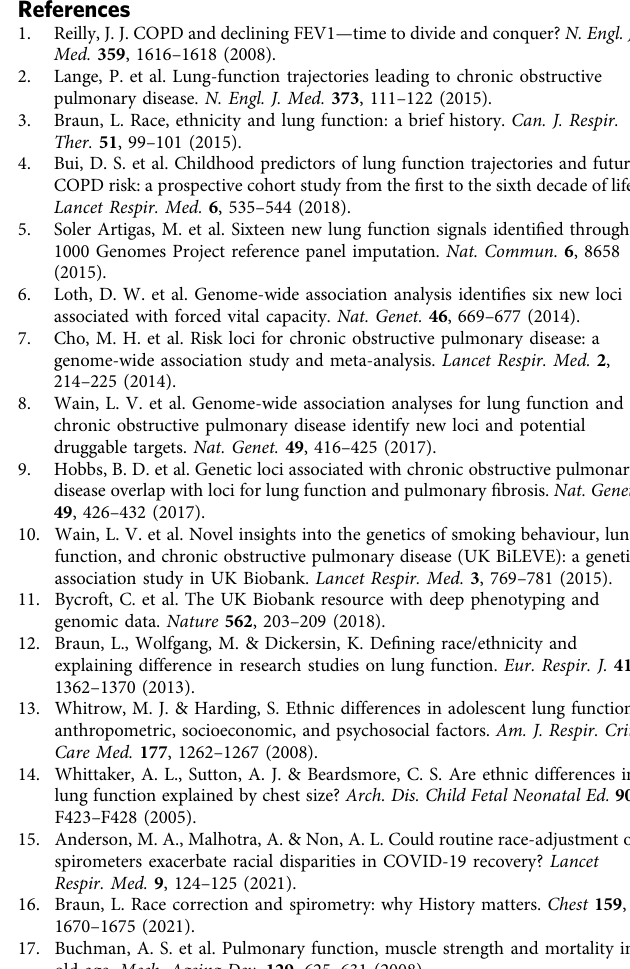
tableau.com/app/pro fi le/musalula.sinkala7788/viz/FEV1VariantsbyChromosome/Chromosome Filter, https://public.tableau.com/app/pro fi